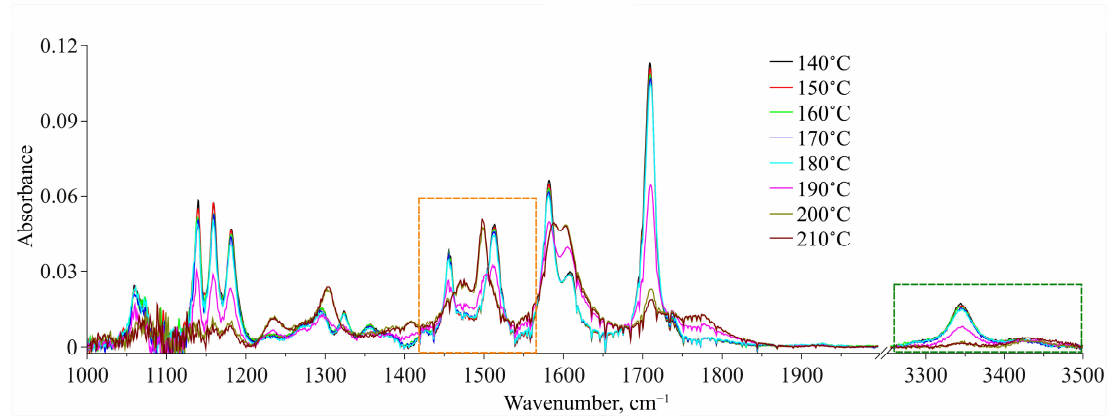
Figure 8. IR spectra of MA dissolved in scCO 2 under isochoric heating conditions. The areas bounded by rectangles correspond to the analytical spectral domains.